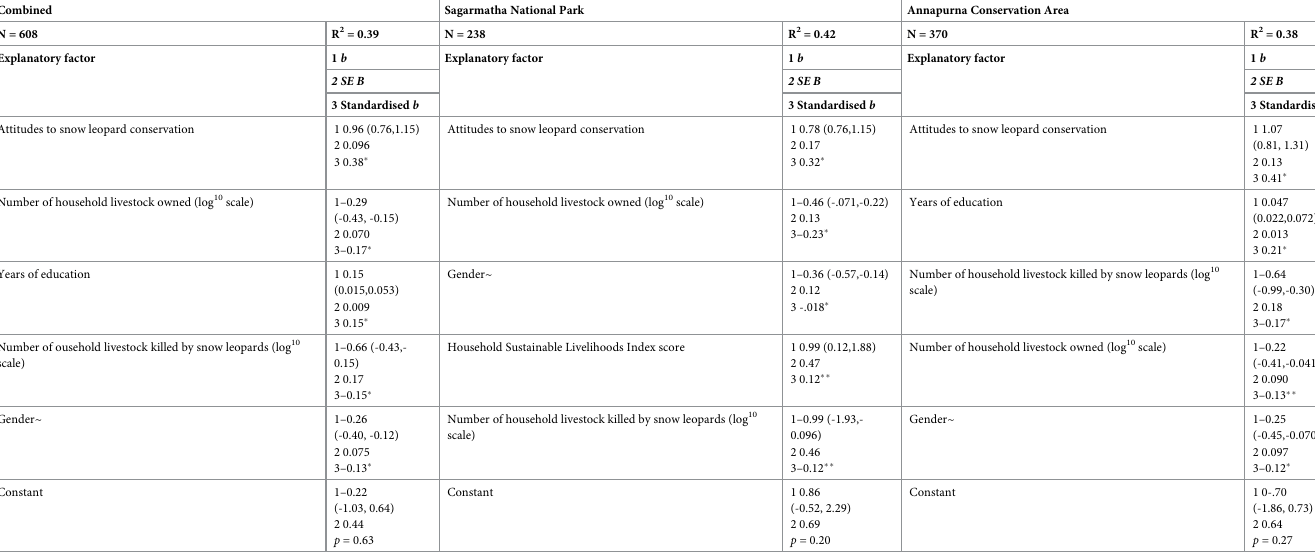
Linear models of factors explaining individual attitudes to snow leopards, with 95% bias corrected and accelerated confidence intervals reported in parentheses. Confidence intervals and standard errors were based on 1000 bootstrap samples. Rankings based on standardised b scores. � p = � 0.01.